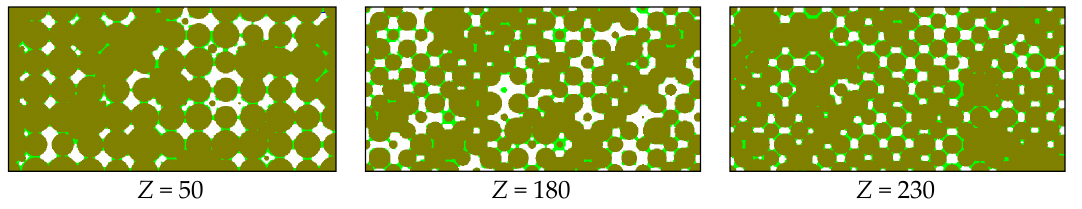
Figure 13. Different cross sections of the simplified model for the tight sandstone core 24 # .